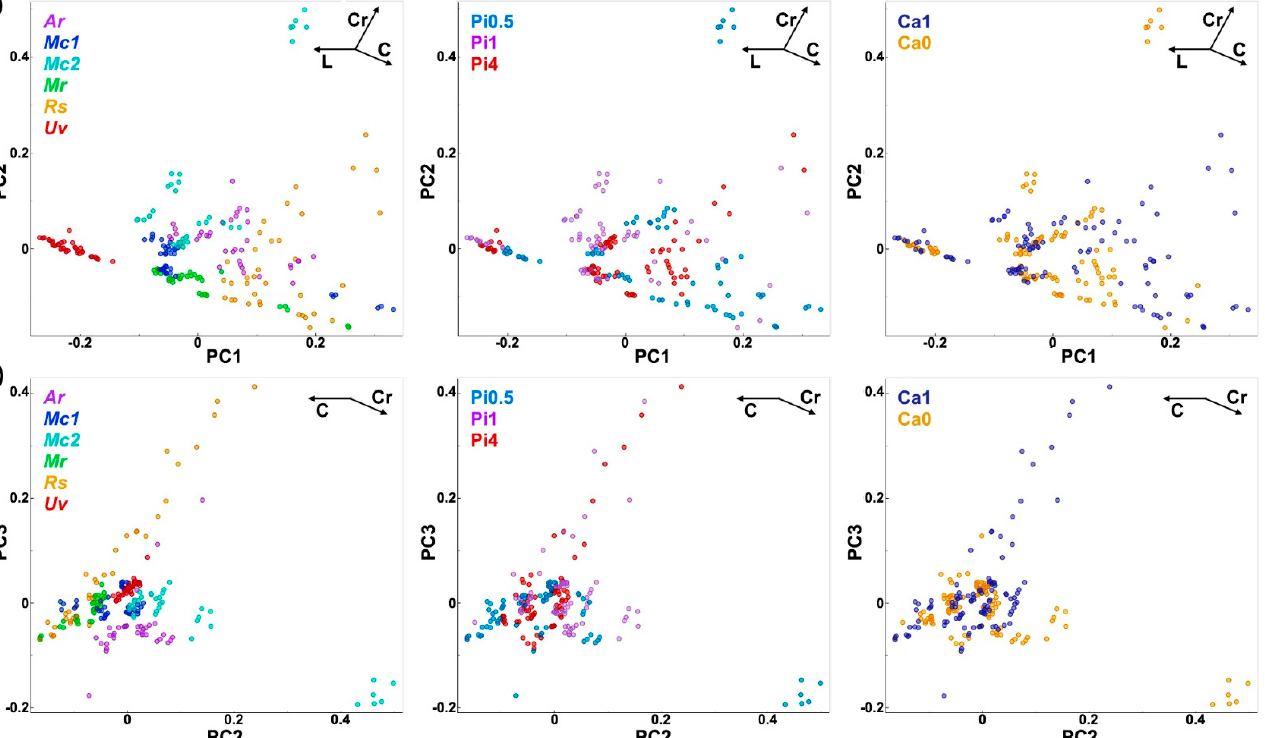
Figure 7. PCA of FT-Raman spectra of fungi grown at different phosphates and calcium concentrations. ( a ) Score plots of PC1 and PC2, ( b ) PC2 and PC3, and ( c ) the first three loading vectors. Score plots are labeled according to strains: Amylo- myces rouxii ( Ar ), Mucor circinelloides VI 04473 ( Mc1 ), Mucor circinelloides FRR 5020 ( Mc2 ), Mucor racemosus ( Mr ), Rhizopus stolonifer ( Rs ), and Umbelopsis vinacea ( Uv ) (left), phosphates concentrations (middle), and calcium availability (right). Vec- tors are approximating the increase in relative amount of the metabolites: lipids (L), cell wall carbohydrates (C), and ca- rotenoids (Cr). The explained variances for the first five principal components are 47.3%, 26.9%, 15.8%, 3.8%, and 1.4%. 2.3. Quantitative Determination of Chemical Constituents of Fungal Biomass Based on Vibrational Spectra The influence of growth conditions on chemical composition of fungal biomass can be estimated by using Raman intensity ratios of Raman bands related to specific chemical constituents. Figure 8a shows that ratio of Raman intensities at 1747 cm − 1 (related to lipids) and 1445 cm − 1 (related to total biomass) provides a satisfactory estimate of total fungal